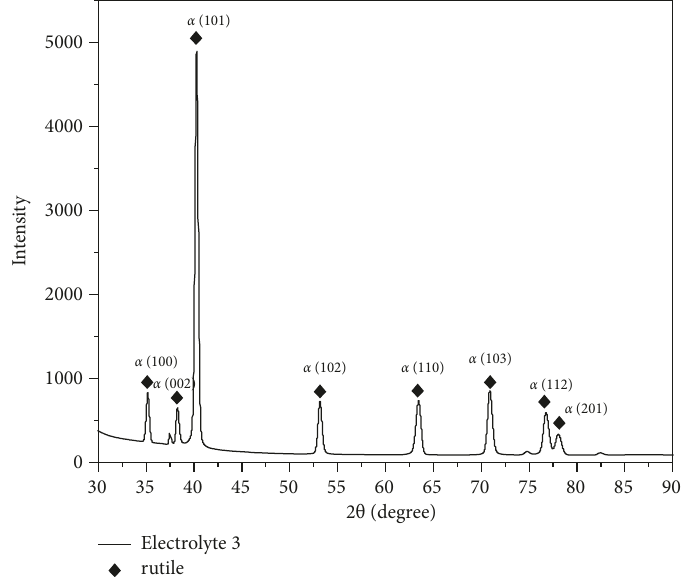
Figure 8: The XRD spectrum of SLM built Ti-6Al-4V specimen electropolished with electrolyte 3.